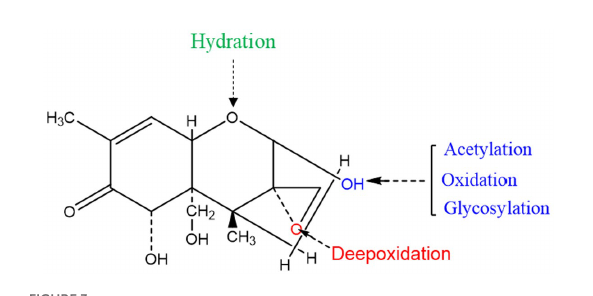
FIGURE 3 Detoxification of the target toxic group in the DON